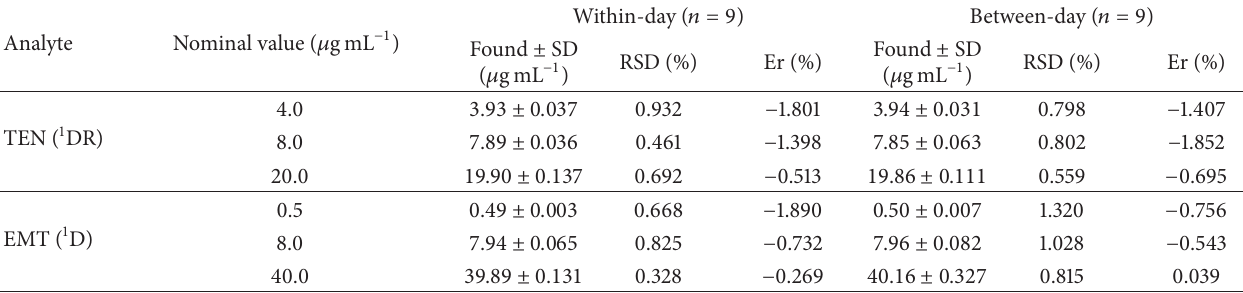
Table 2: Accuracy and precision of the proposed spectrophotometric methods for analysis of TEN and EMT. Analyte